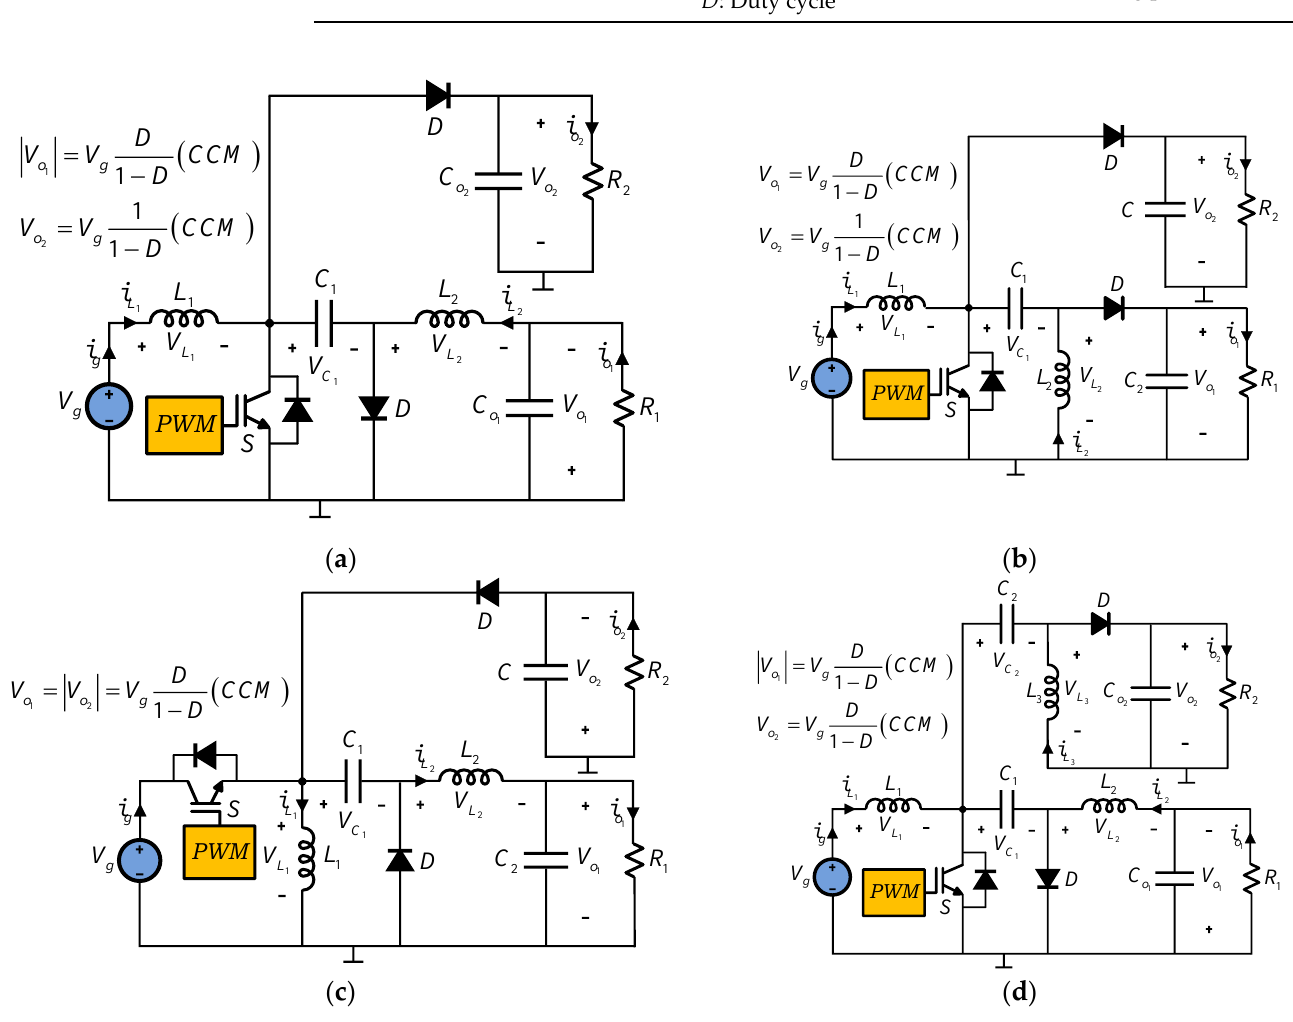
Figure 9. Two-output-type converter combinations. ( a ) Boost –Ćuk converter co mbination. ( b ) Boost – SEPIC converter combination. ( c ) Buck – Boost – Zeta converter combination. ( d ) SEPIC –Ćuk converter combination.